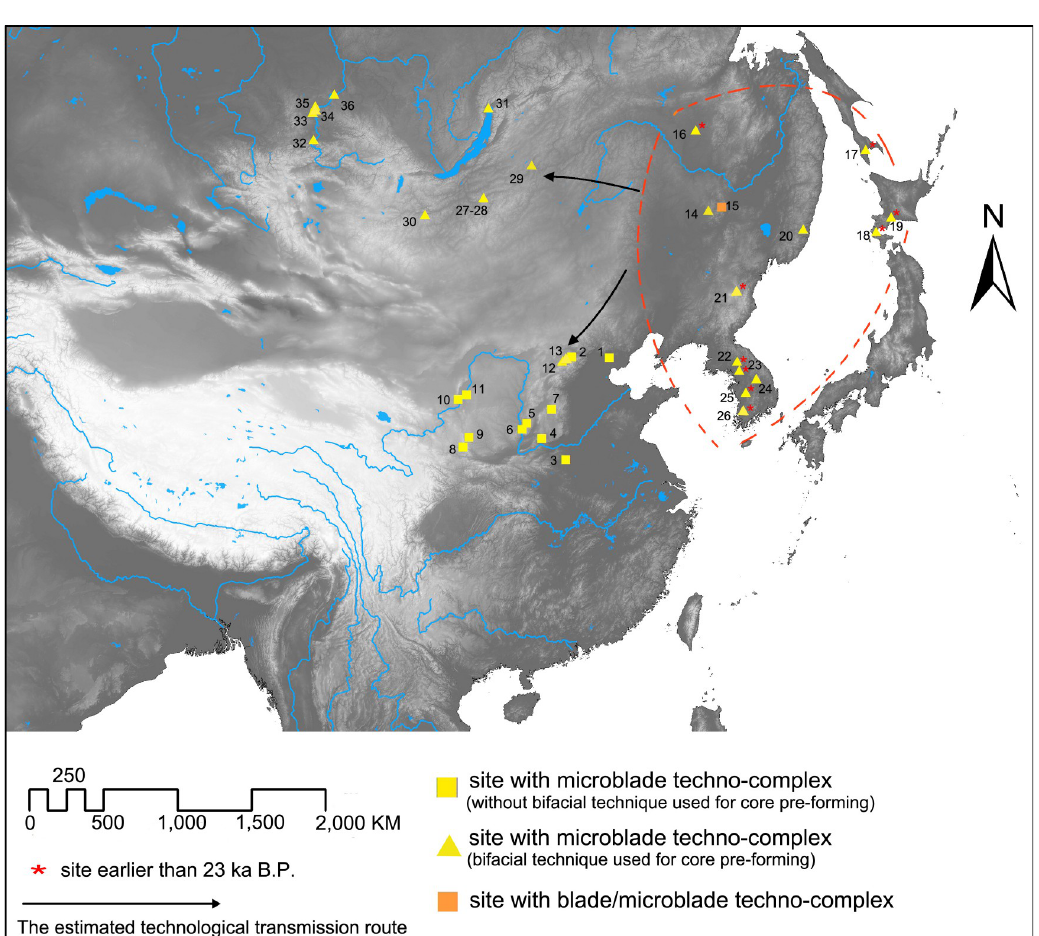
Fig 9. The distribution of sites with different techno-complexes and the estimated technological transmission route between northern China and Mongolia/Siberia during 23–11 cal ka BP. The base map raster is made from the USGS digital elevation map data from http://earthexplorer.usgs.gov/. (1: Mengjiaquan; 2: Erdaoliang; 3: Lingjing; 4: Xiachuan; 5: Xueguan; 6: Shizitan-1; 7: Mengjiazhuang; 8: Shixiakou; 9: PY-03; 10: Pigeon Mtn.; 11: Shuidonggou-12; 12: Hutouliang; 13: Maanshan; 14: Taoshan;